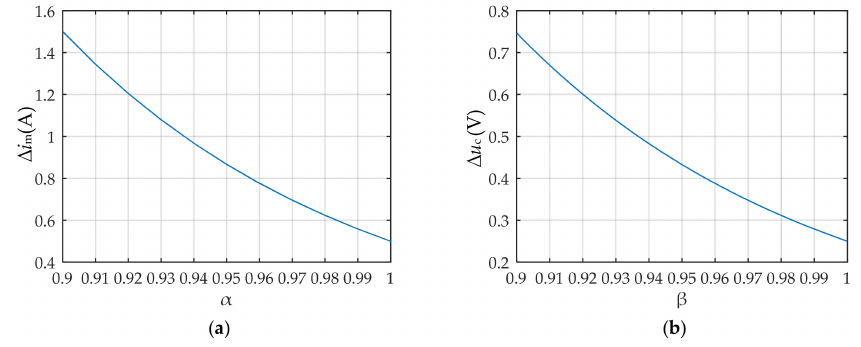
Figure 4. ( a ) The relationship between the inductor current ripple ∆ i m and the order α . ( b ) The relationship between the output voltage ripple ∆ u c and the order β